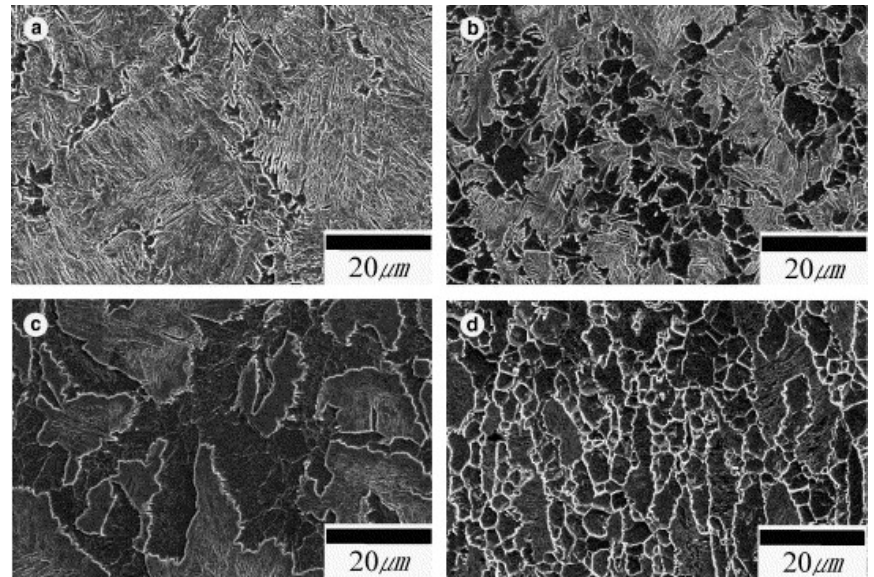
Figure 8. SEM micrographs showing the evolution of ferrite grain structure at ( a ) 800 °C and ε = 0.5; ( b ) 800 °C and ε = 0.8; ( c ) 750 °C and ε = 0.25; and ( d ) 750 °C and ε = 0.7 [66] .